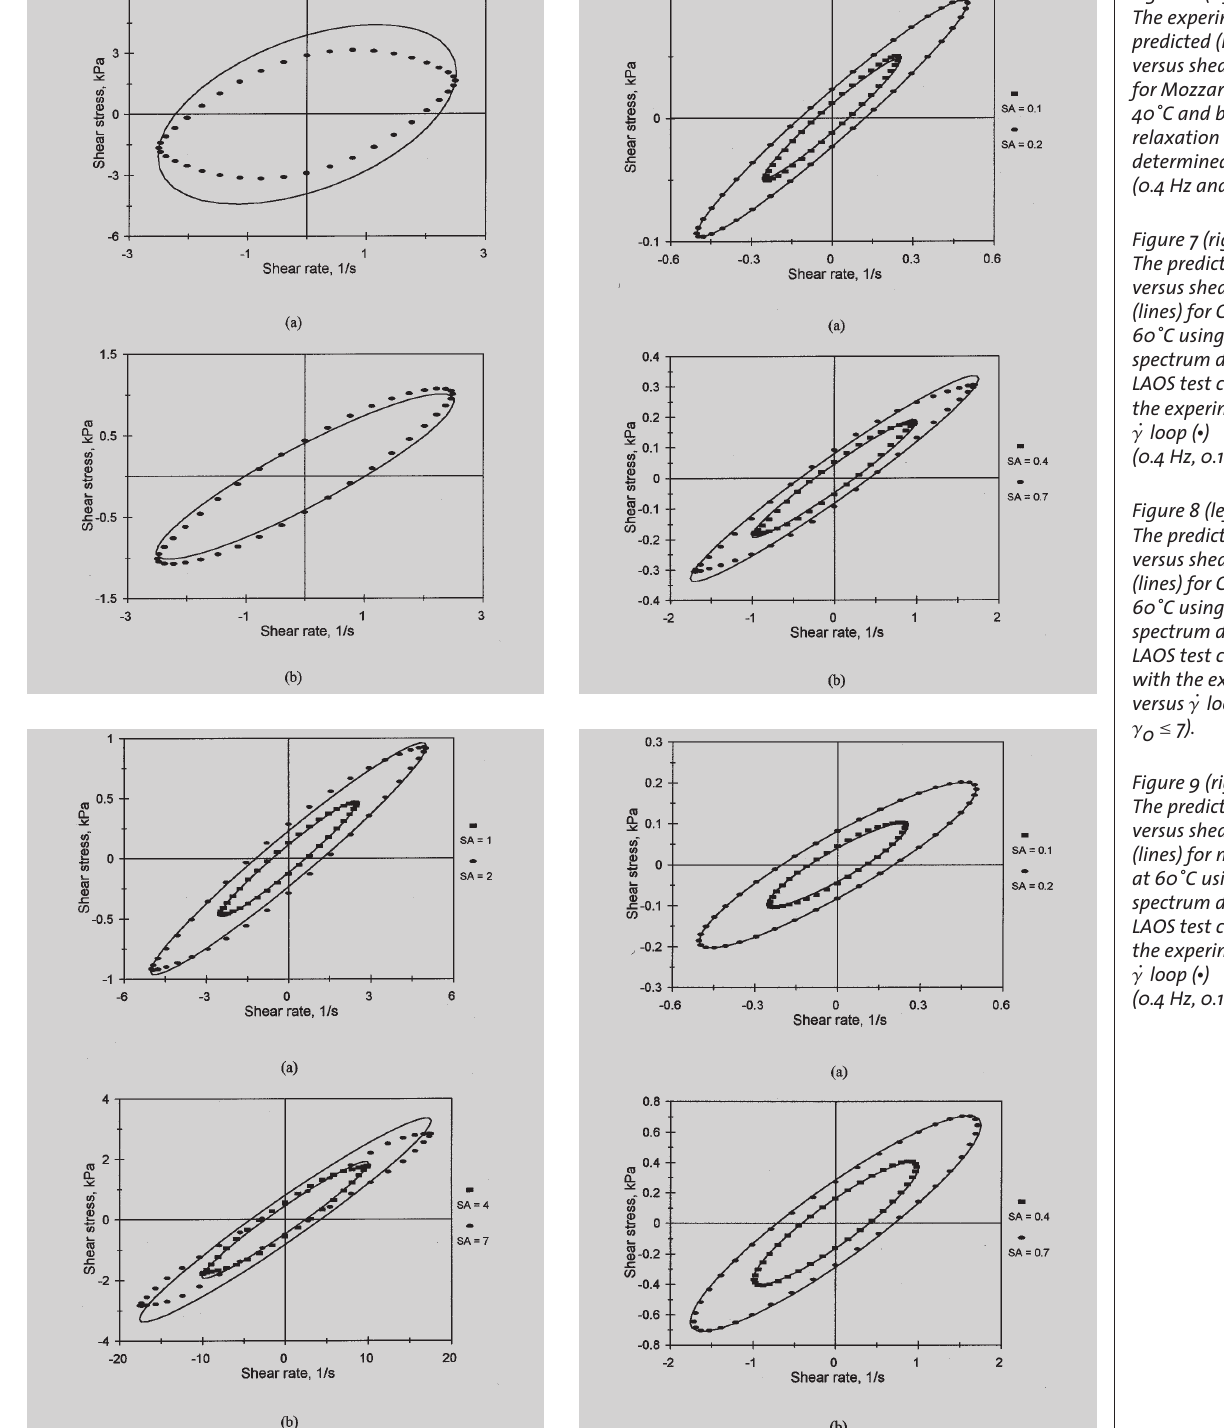
Figure 6 (left above): The experimental ( ∑ ) and predicted (lines) shear stress versus shear strain rate loop for Mozzarella cheese at a.) 40˚C and b.) 60˚C using the relaxation spectrum determined from LAOS test (0.4 Hz and g 0 = 0.2). Figure 7 (right above): The predicted shear stress ( ∑ ) versus shear strain rate loop (lines) for Cheddar cheese at 60˚C using the relaxation spectrum determined from LAOS test compared with the experimental s versus g · loop ( ∑ ) (0.4 Hz, 0.1 £ g 0 £ 0.7). Figure 8 (left below): The predicted shear stress ( ∑ ) versus shear strain rate loop (lines) for Cheddar cheese at 60˚C using the relaxation spectrum determined from LAOS test compared with the experimental s versus g · loop ( ∑ !) (0.4 Hz, 1 £ g 0 £ 7). Figure 9 (right below): The predicted shear stress ( ∑ ) versus shear strain rate loop (lines) for mozzarella cheese at 60˚C using the relaxation spectrum determined from LAOS test compared with the experimental s versus g · loop ( ∑ ) (0.4 Hz, 0.1 £ g 0 £